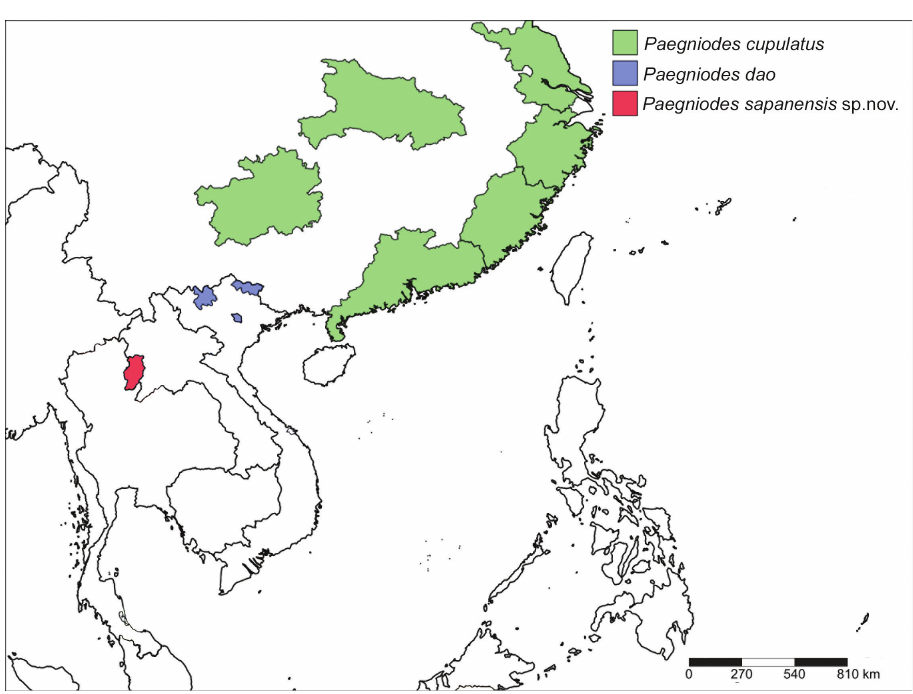
Figure 12. Distribution of the genus Paegniodes Eaton,